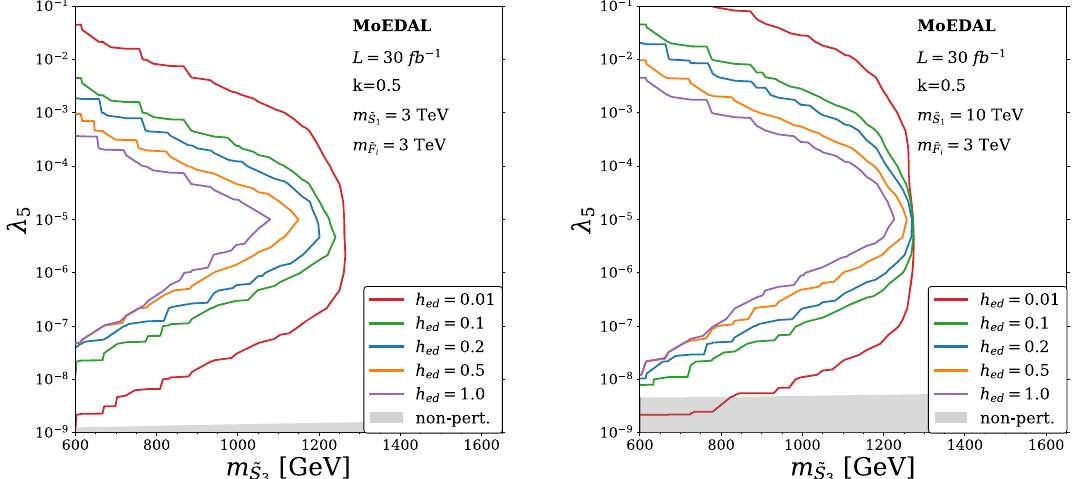
= 3 and 10 TeV in 1